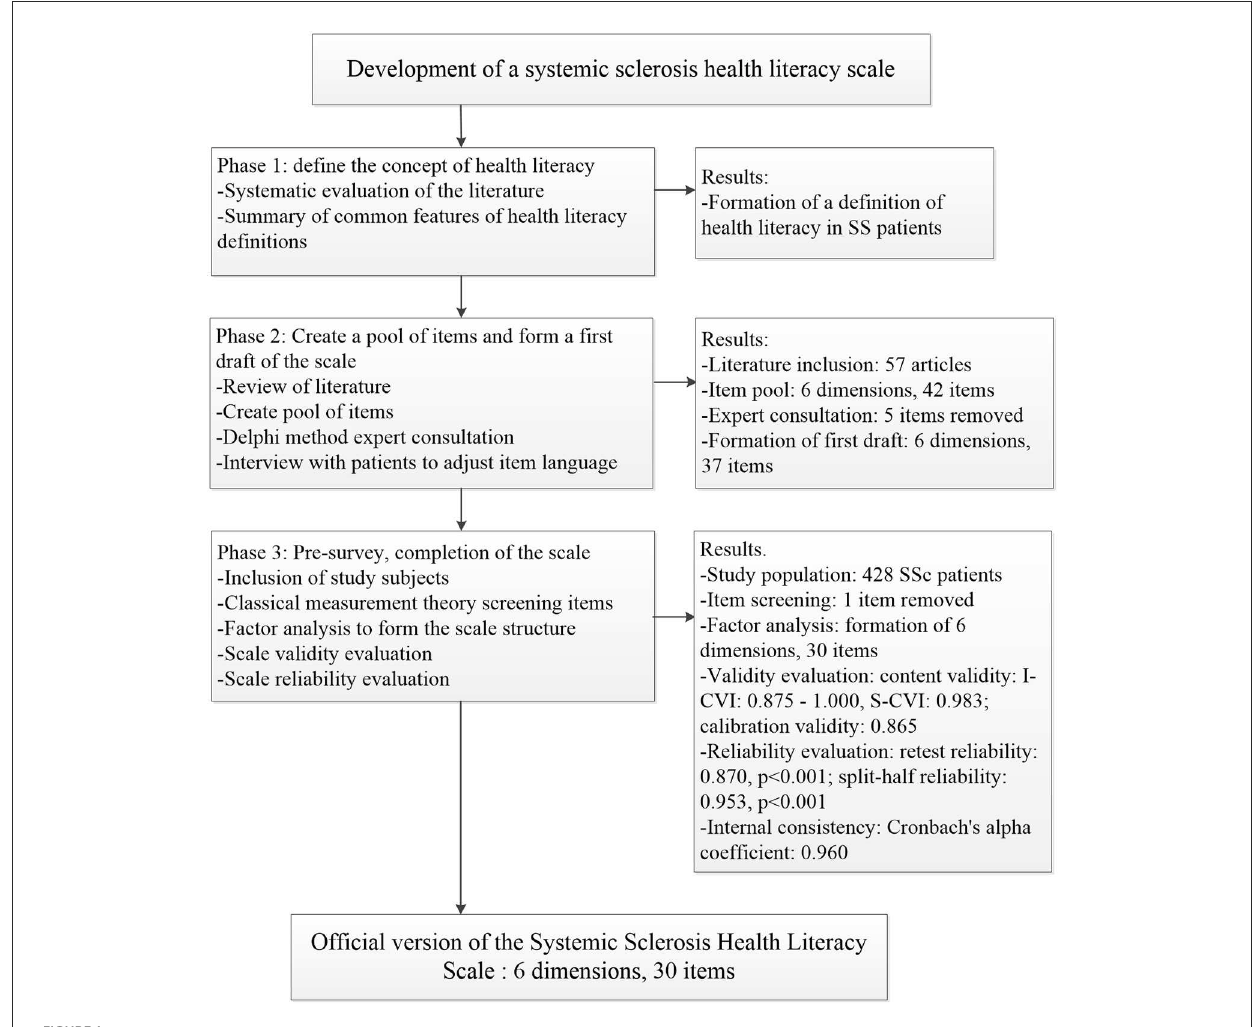
FIGURE1 Flow chart of systematic sclerosis Health Literacy Scale